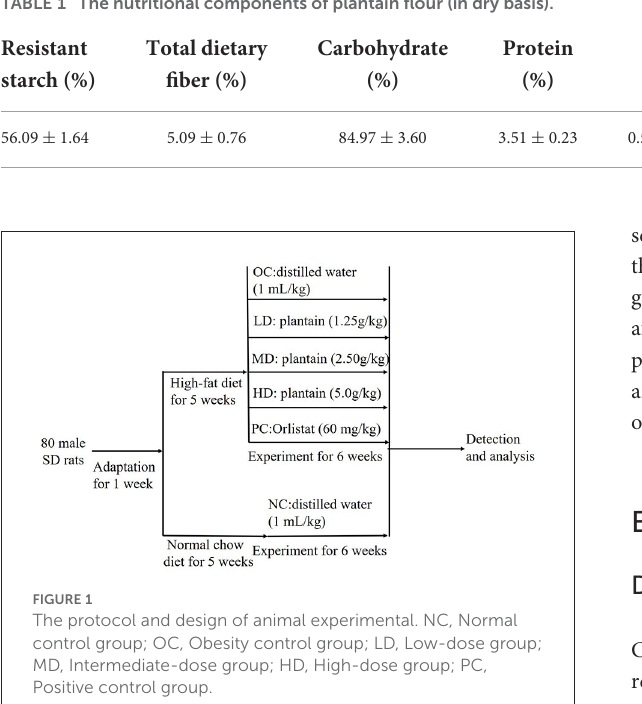
TABLE 1 The nutritional components of plantain flour (in dry basis).